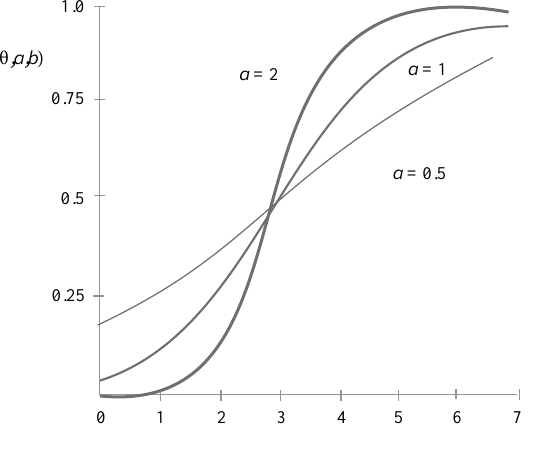
Fig. 2. Graph of function P (θ, a, b ) for b = 3, a = 0.5, 1,